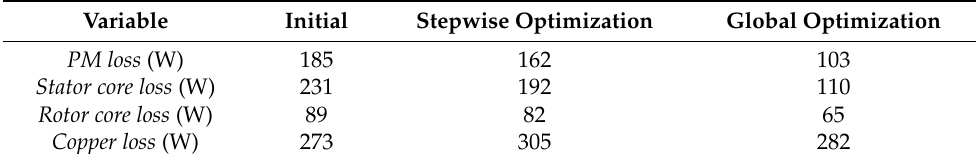
Table 5. Loss of each part before and after optimization.